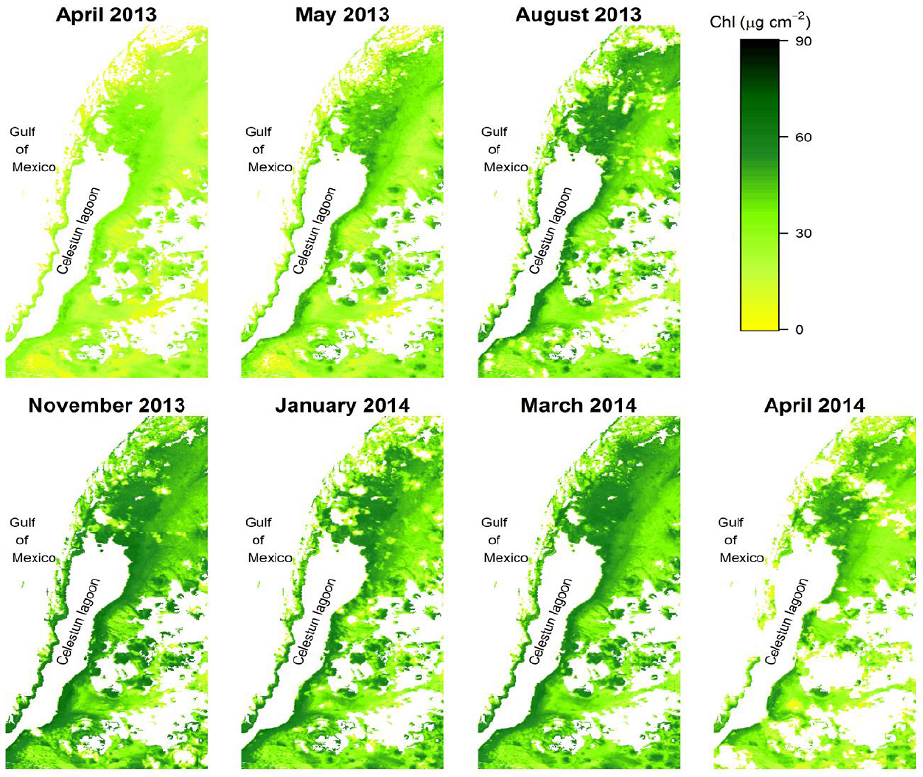
Figure 9. Remote sensing-based maps of the spatiotemporal variation in CC ( μ g·cm − 2 ) estimated using the relationship between Landsat 8 NDVI green and Chl measurements obtained in the field. The non-mangrove pixels have been masked out.